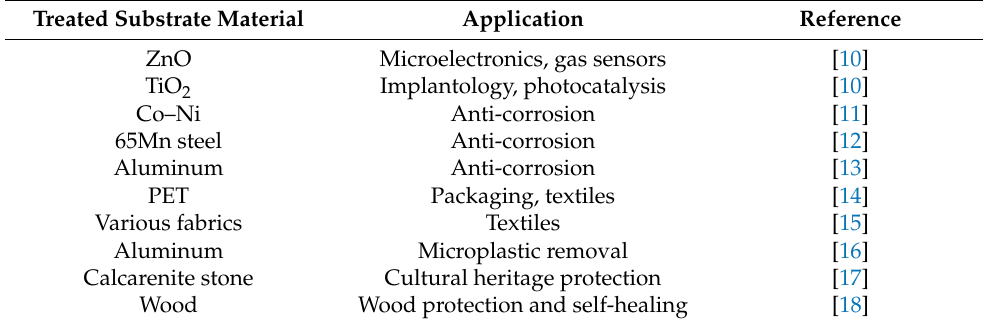
Table 1. Structured materials and applications, described in the articles which are included in the present Special Issue, titled “Superhydrophobic and Superoleophobic